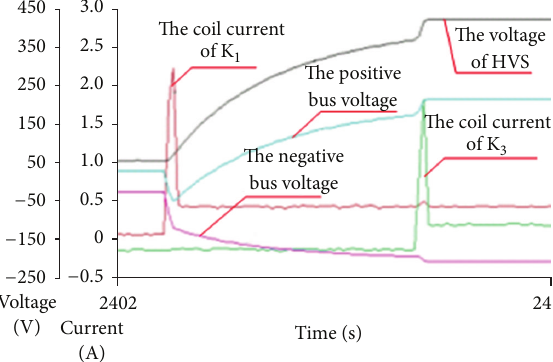
Figure 16: The test trial curve of high voltage precharge.